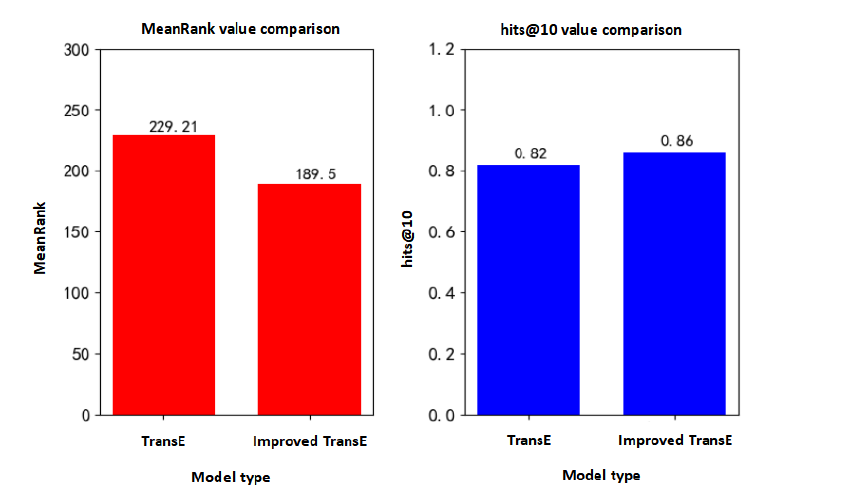
Figure 13. Comparison of MeanRank value and hit@10 value before and after